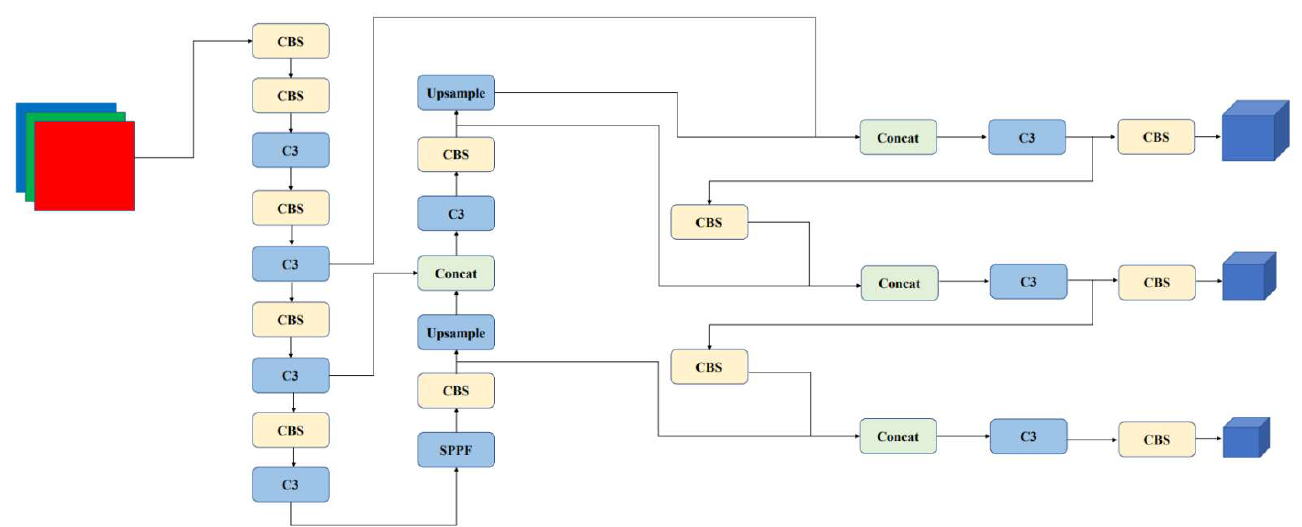
Figure 1. The framework of YOLOv5s. The network consists of five parts: input, backbone, neck, prediction, and output.